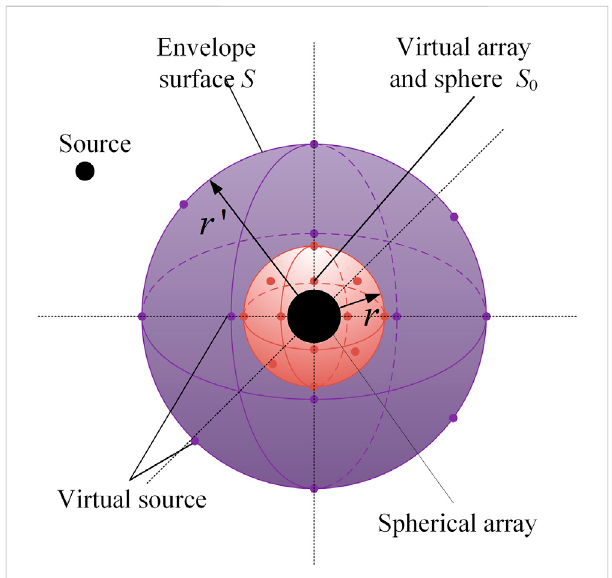
FIGURE 1 Schematic diagram of virtual SMA extrapolation method. The black sphere represents the actual SMA, the red sphere represents the virtual SMA, and the purple sphere represents the envelope surface where the virtual sources are